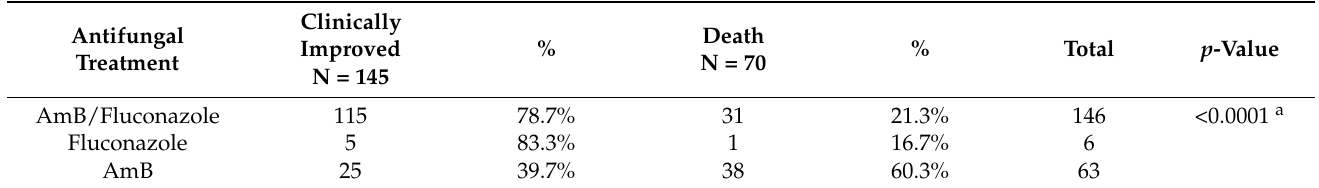
Table 3. Antifungal treatment applied to patients with cryptococcosis according to clinical evolution, 2008–2018, JBBUH, Par á , Brazil.